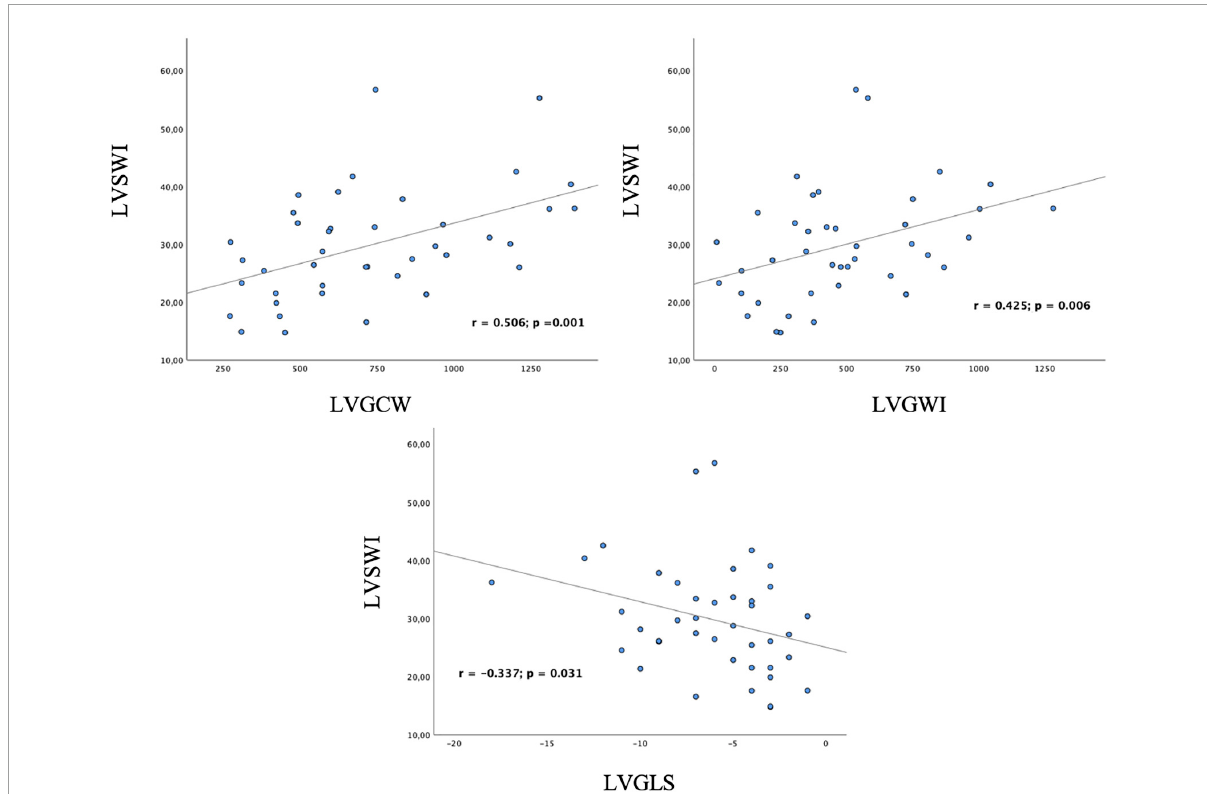
FIGURE2 Correlation of left ventricular myocardial work indices and global longitudinal strain with invasive measurement of left ventricular stroke work index. GCW and GWI significantly correlate with invasive measurement of stroke work; GLS significantly correlates as well. LVSWI, left ventricular stroke work index; LVGCW, left ventricular global constructive work; LVGWI, left ventricular global work index; LVGLS, left ventricular global longitudinal strain.